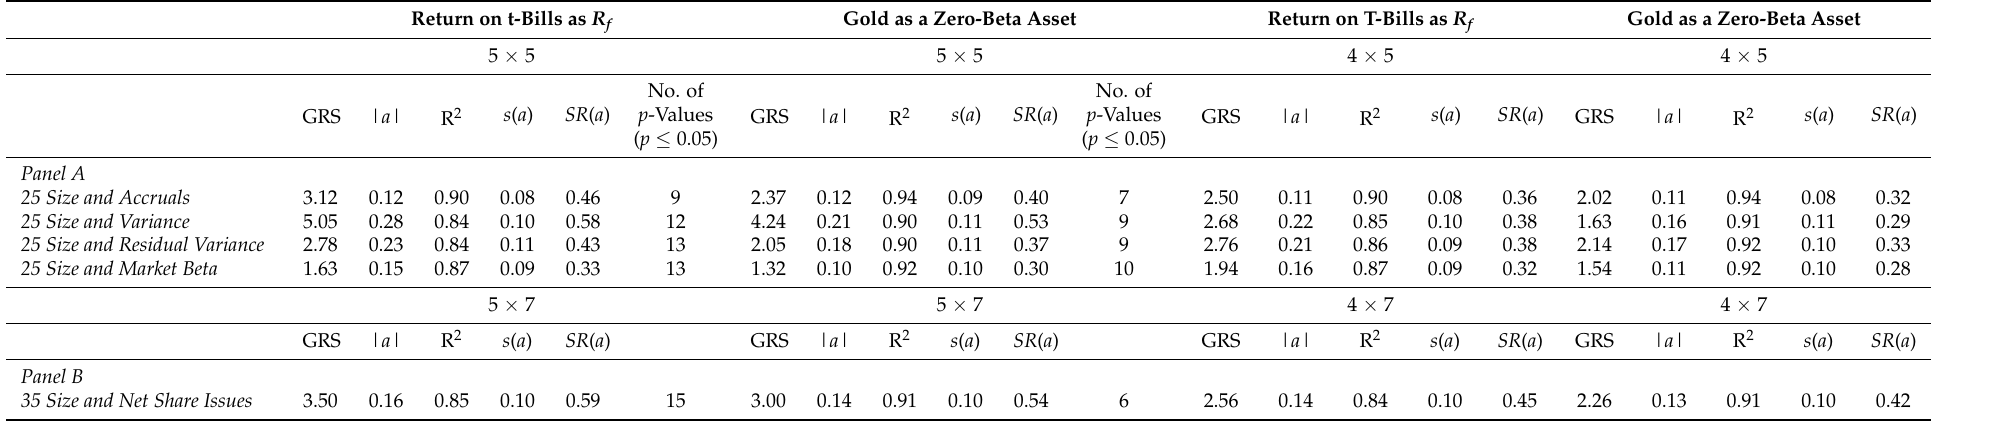
Table 14. Statistical summary of GRS tests to explain the three-factor and G-three-factor regressions from January 1981 to December 2015. The GRS statistic tests the null hypothesis that the alphas of all portfolios are jointly equal to zero. | a | is the average absolute alpha; R 2 is the mean-adjusted R-squared; s ( a ) is the mean standard error of alphas; and SR ( a ) is the average Sharpe ratio of alphas. The critical values for the GRS statistic are 90%: 1.41; 95%: 1.56; 97.5%: 1.69; 99%: 1.86, and 99.9%: 2.25. Panel A shows results on 25 size and variance, 25 size and residual variance, 25 size and market beta portfolios, and Panel B shows results on 35 size and net share issues portfolios with (5 × 5) and without microcaps (4 ×